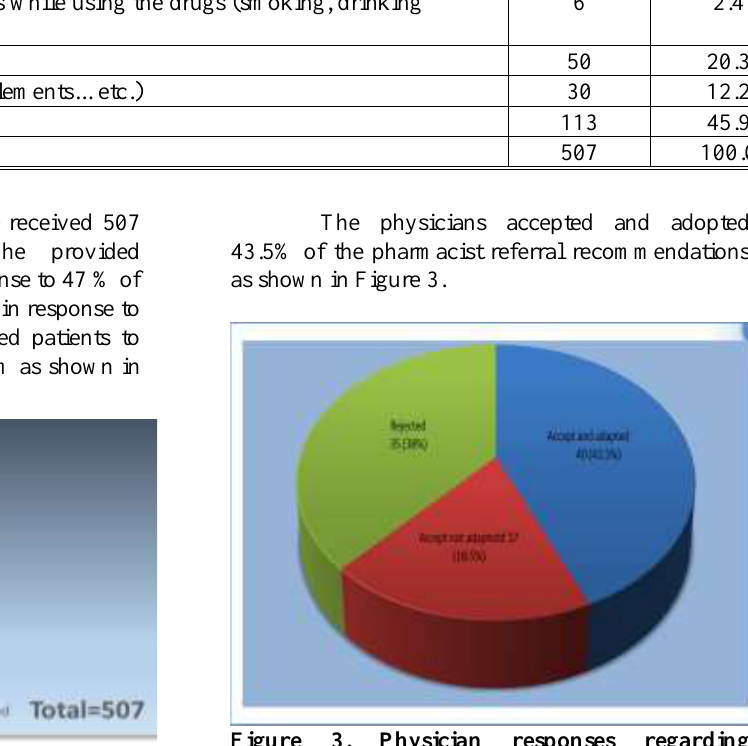
Figure 1. The pharmacist response to patient questions